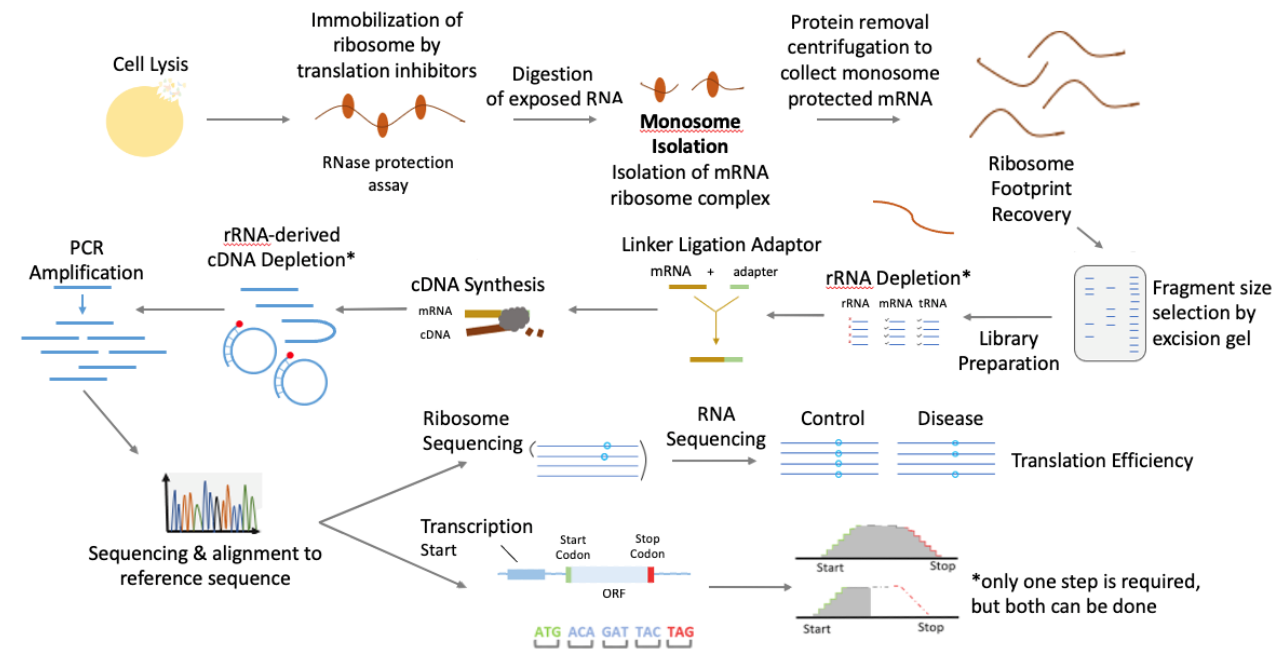
Figure 1. Schematic illustration of the current workflow of ribosomes. The experiment starts with cell lysis, which isolates and immobilizes the mRNA ribosome complexes, and is followed by nuclease digestion of mRNA sequences that are not protected by associated ribosomes. Purification of the mRNA fragments shielded by the ribosomes is then carried out, followed by standard deep sequencing protocols, such as library preparation.